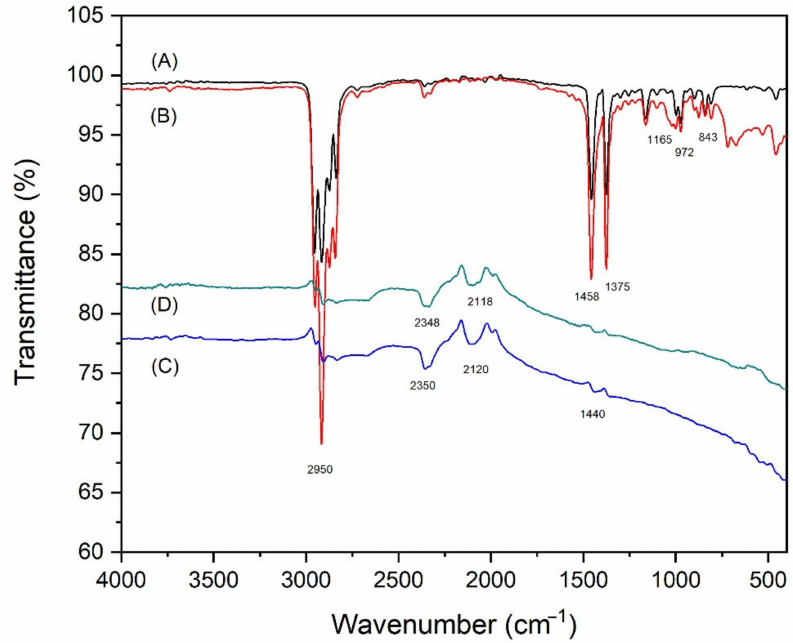
Figure 9. FTIR spectra of ( A ) vPP, ( B ) rPP30, ( C ) rPP30CBW, and ( D ) rPP30CBNW composites.